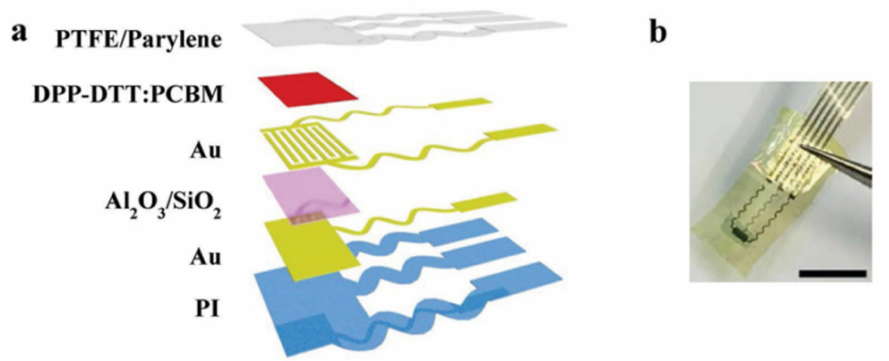
Figure 17. ( a ) Schematic of the device structure of the flexible OPT, ( b ) figure of a freestanding OPT. Reprinted with permission from ref. [15]. Copyright 2017 John Wiley &